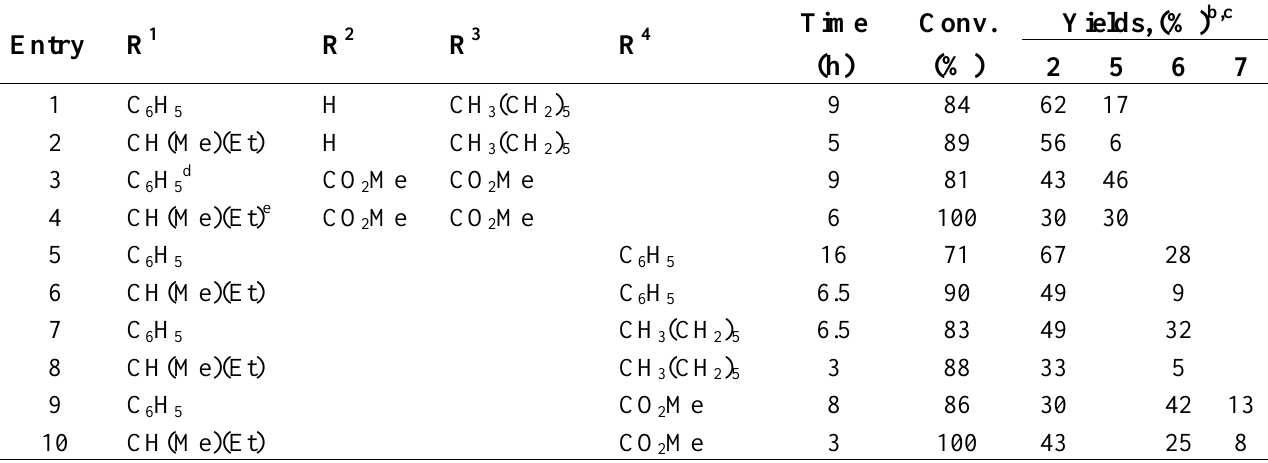
Table 2. Preparation of isoxazole and isoxazoline derivatives by aldoximes oxidation in the presence of alkenes or alkynes a